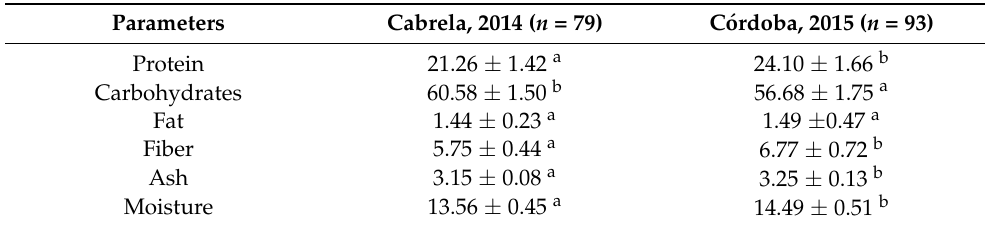
Table 1. Averages ± standard deviations of protein, carbohydrates, fat, fiber, ash and moisture contents (g/100 g) obtained for common bean accessions cropped in the two contrasting environments (Cabrela and C ó rdoba). In each row different letters indicate significant differences ( p < 0.05) and equal letters the absence of differences ( p >